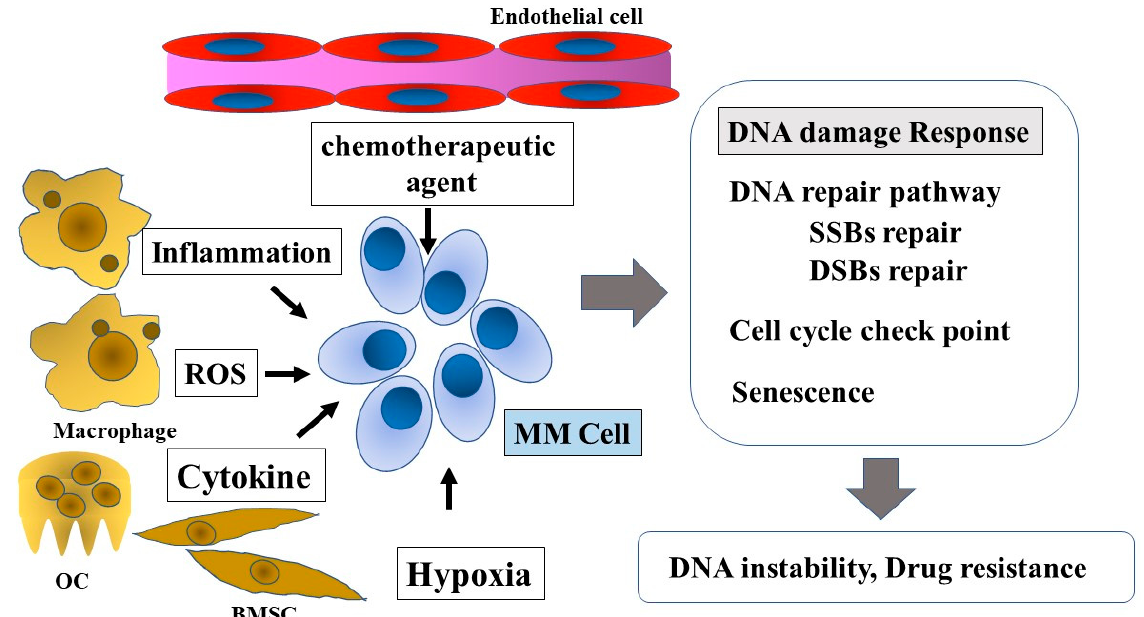
Figure 1. DNA damage response in multiple myeloma and the tumor microenvironment. Tumor microenvironment factors, such as chemotherapeutic agents, inflammation, ROS, cytokines, genotoxic stress, and hypoxia, influence the DNA damage response in MM cells. The DNA damage response affects disease progression and drug resistance. ROS, reactive oxygen species; OC, osteoclast; BMSC, bone marrow stromal cell; MM Cell, multiple myeloma cell; SSBs, single-strand breaks; DSBs, double-strand breaks.